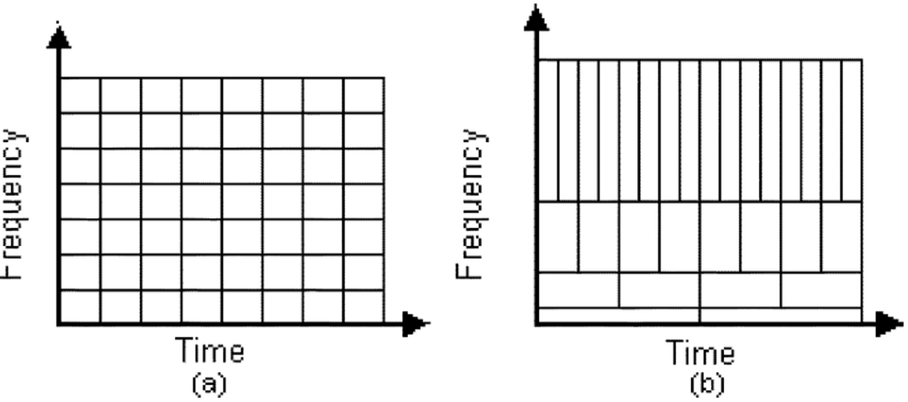
Figure 5. Comparison of the window widths during signal transformation with the STFT ( a ) and WT ( b